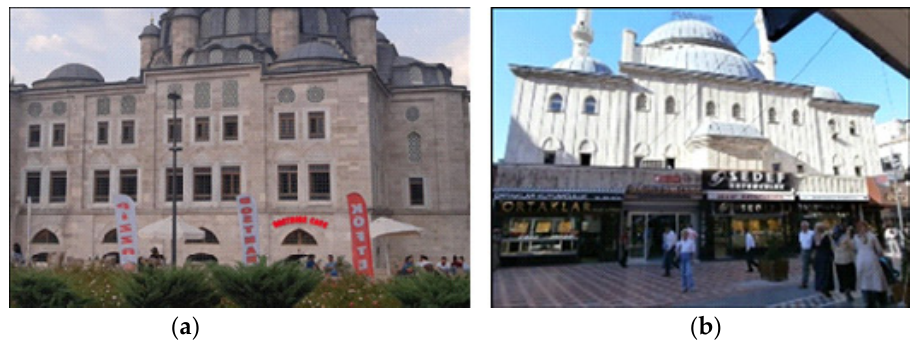
Figure 6. ( a ) Tezkireci Osman Efendi Mosque, İ stanbul; ( b ) Ş erefiye Mosque, Sakarya.